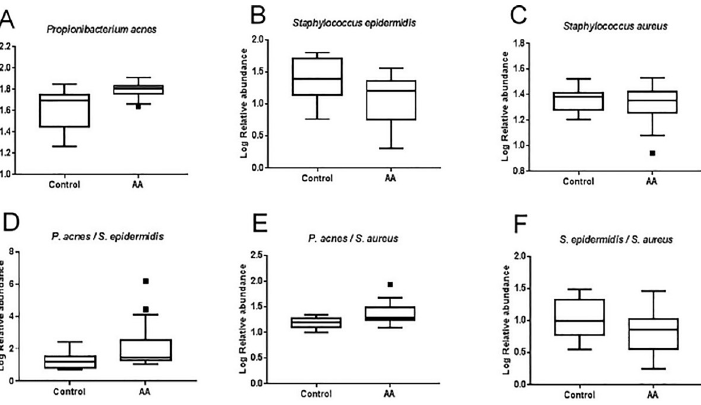
Fig 2. Relative abundance of main bacterial species on the scalp of AA and control subjects by RT qPCR. Box and Whisker comparing the log relative abundance of P . acnes , S . epidermidis and S . aureus collected by swabbing the scalp. (A) Log Relative abundance of P . acnes in Control and AA subjects. (B) Log Relative abundance of S . epidermidis in Control and AA subjects. (C) Log Relative abundance of S. aureus in Control and AA subjects. Ratios P. acnes/ S. epidermidis (D), P. acnes/ S. aureus (E) and S. epidermidis / S. aureus (F) in Control and AA subjects. Values are presented as mean +/- SEM, in duplicate. Box-and-Whiskers plot showing median with 25th to 75th percentile. The center line of each box represents the median; data falling outside the whiskers range are plotted as outliers of the